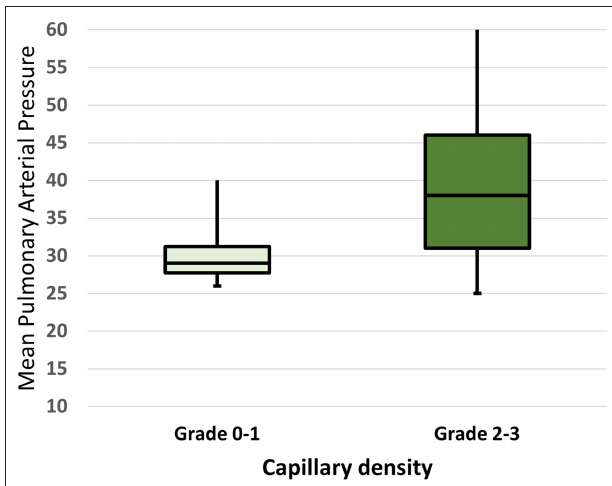
FIGURE 1 | Mean pulmonary arterial pressure (mPAP) in SSc patients with a capillary density score of 0–1 vs. 2–3. The horizontal line in the box represents the median, lower and upper boundaries of the box represent the 25th (Q1) and the 75th (Q3) percentiles. Whiskers represent the minimum and the maximum value. The minimum, 25th, 50th (median) and 75th percentile and maximum values were 26.0, 27.5, 29.0, 31.5, and 48.5 in those with capillary density score of 0–1. The minimum, 25th, 50th (median) and 75th percentile and maximum values were 25.0, 31.0, 38.0, 46.0, 60.0 in those with capillary density score of 2–3. P -value for comparison: